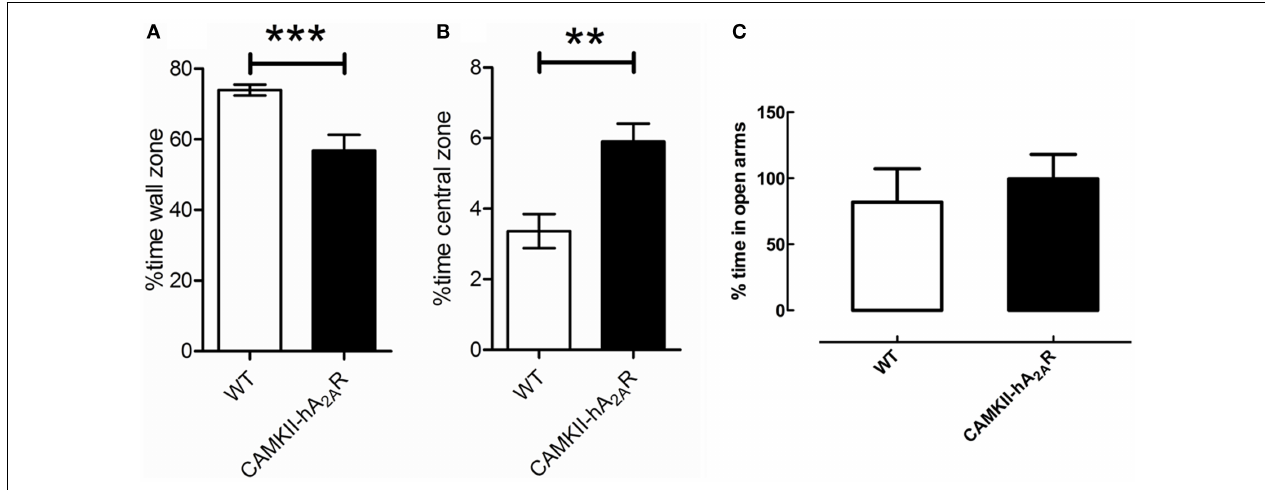
FIGURE 4 | Open-field test . Percentage of time spent (A) at the wall zone and (B) in the central zone. (C) Percentage time in the open arms of the elevated plus maze (EPM). Results are expressed as mean ± SEM. ** p < 0.01; *** p < 0.001.WT: n = 12;Tg(CaMKII-hA2AR): n =